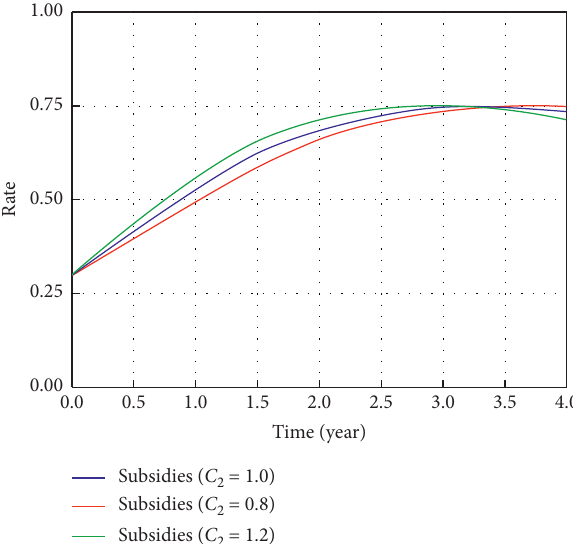
Figure 5: Sensitivity analysis on subsidies for adopting pre- fabricated